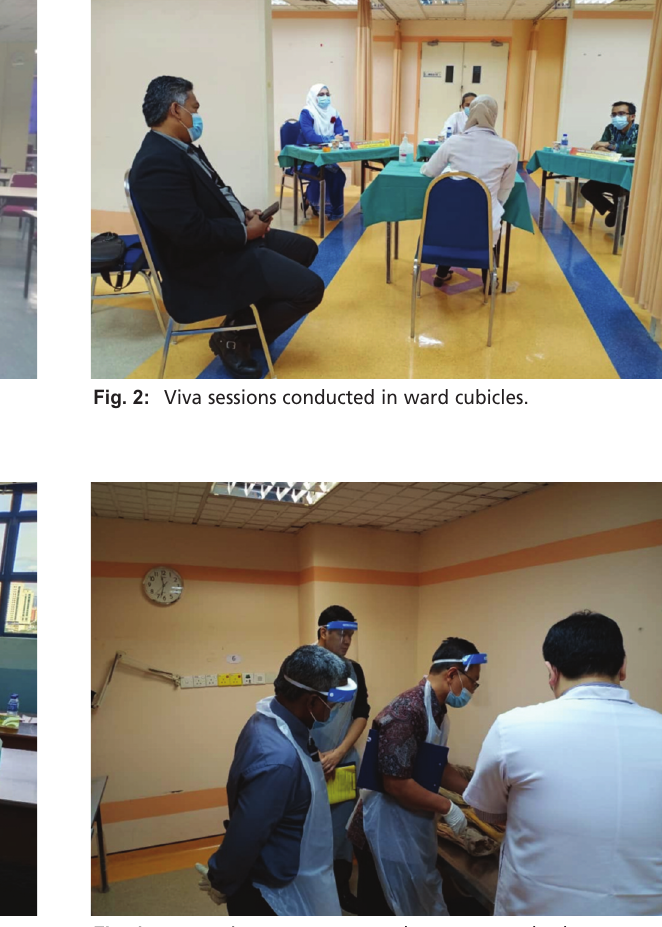
Protective eyewear, mask, apron and gloves were Fig. 4: required for anatomy